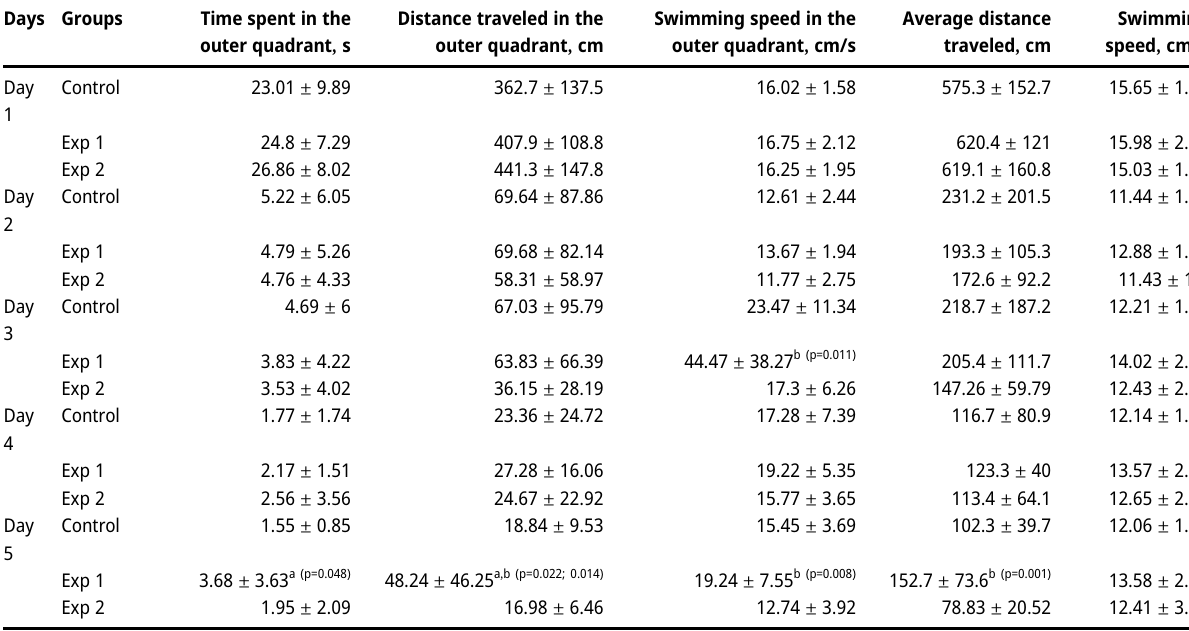
Table  : Intergroup comparison of training period parameters in Morris water maze.